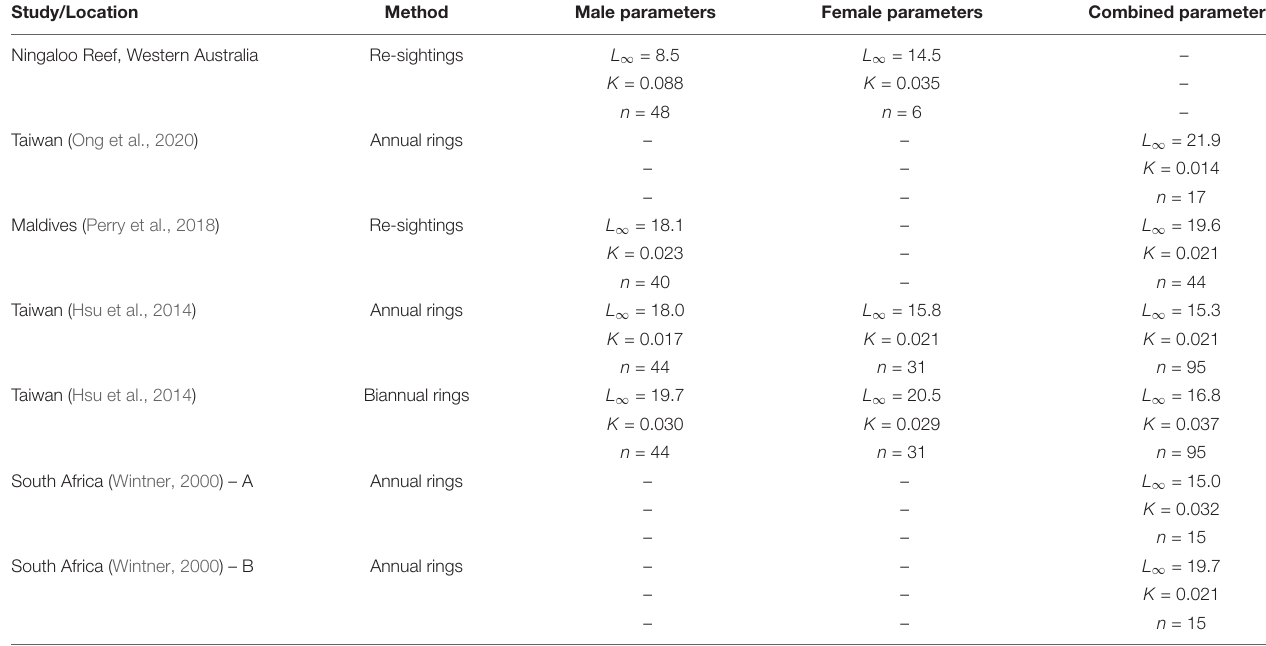
TABLE 1 | von Bertalanffy growth parameter estimates from different studies and regions based on resighting or vertebral data.